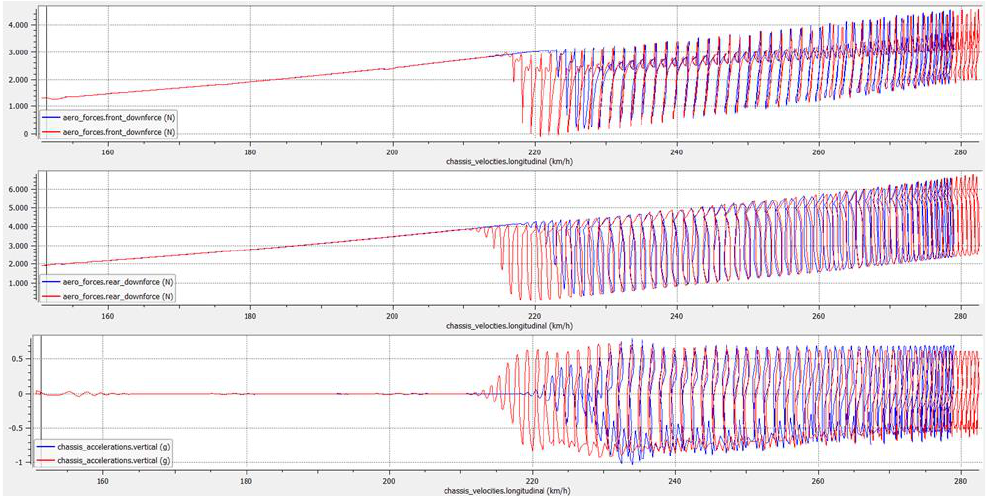
Figure 22. Once porpoising oscillations are triggered, average downforce levels are not affected by bump stop stiffness. In this plot front downforce ( top ), rear downforce ( center ), and vertical acceleration ( bottom ) are